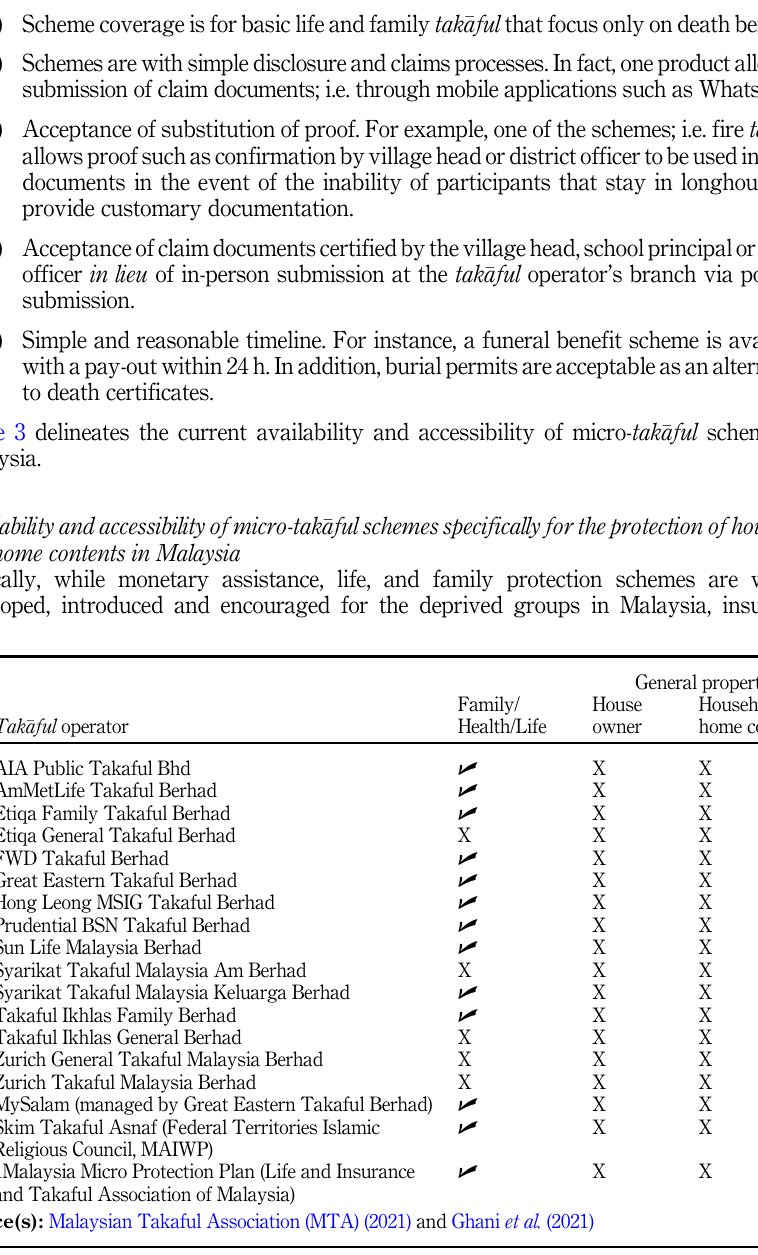
Table 3. Availability and accessibility of micro- tak (cid:1) aful schemes in